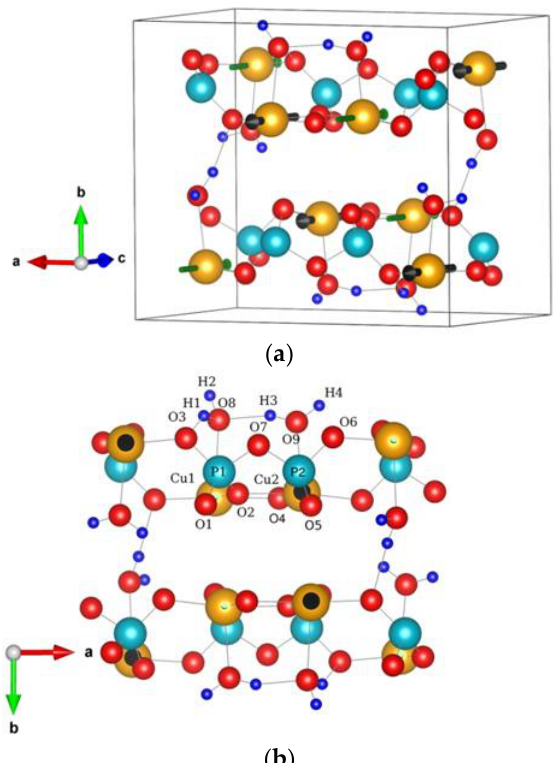
Figure 1. ( a ) Crystal structure of Cu 2 P 2 O 7 (H 2 O) 2 . The orange, blue, red, and navy blue spheres denote copper, phosphorus, oxygen, and hydrogen atoms. Black and green arrows indicate the spin magnetic moment direction of the Cu atoms. ( b ) CuPPD crystal structure viewed from the y-direction showing the details of atomic